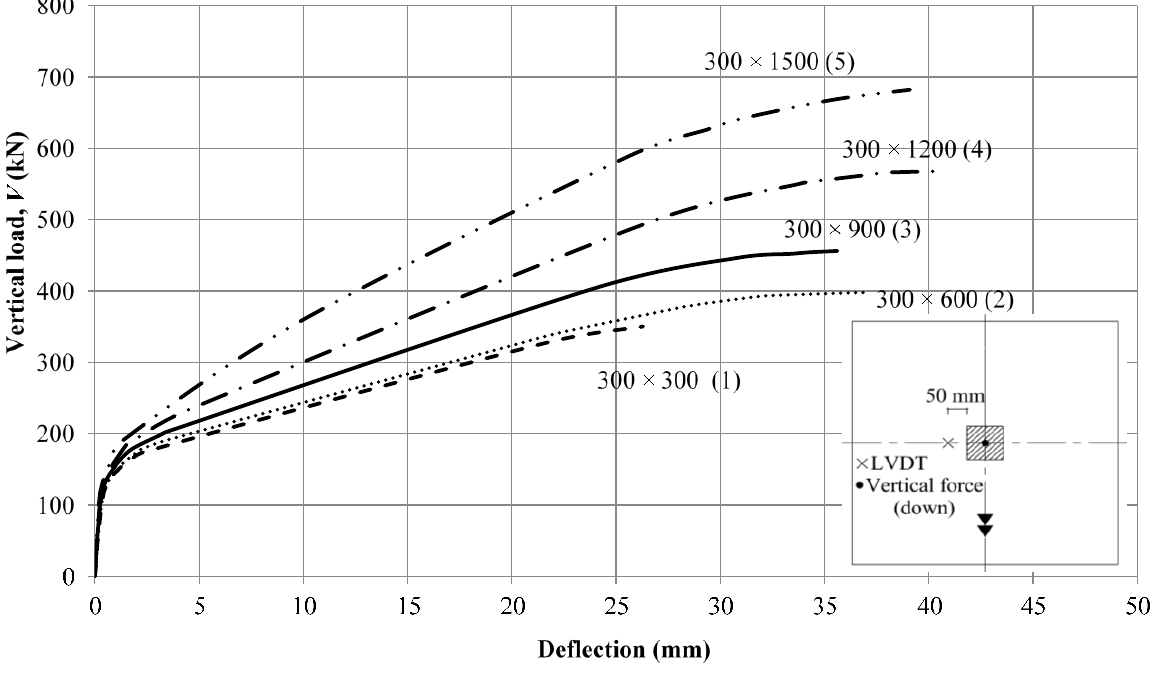
Figure 15. Load-deflection relationship for the models with different column aspect